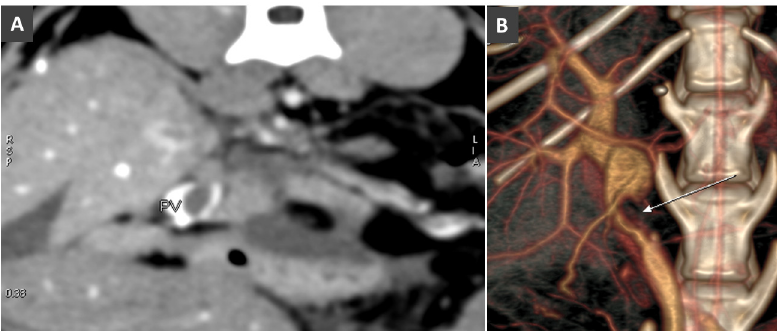
Figure 6. A . Transverse image of the liver at the porta hepatis in a cat with pancreatitis and PV (portal vein) thrombosis (arrow). B . Volume rendered image (ventral view) in the same cat. Note the large filling defect due to the thrombosis (arrow) in the prehepatic PV.